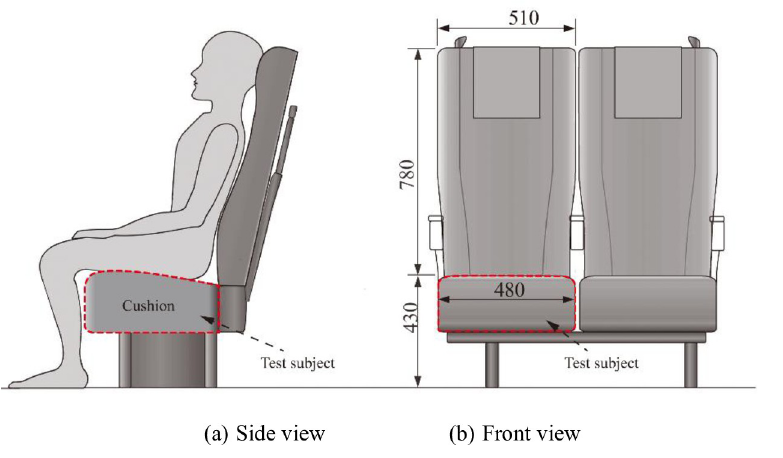
Fig 2. Seat size parameters (unit: Mm). (a) Side view and (b) Front view.